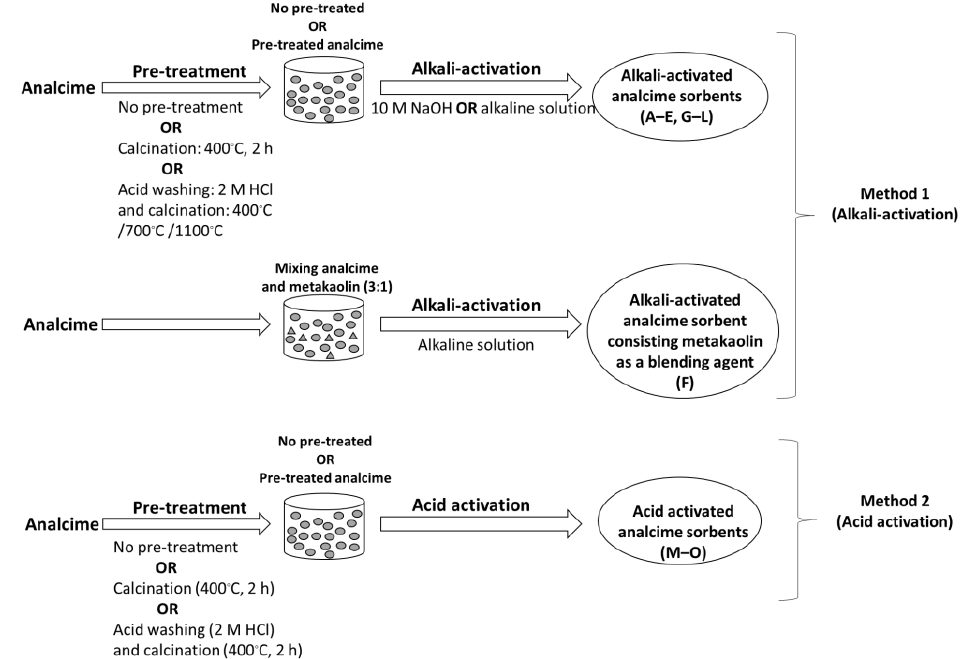
Figure 1. Schematic diagram of the alkali- and acid-activated analcime sorbents.